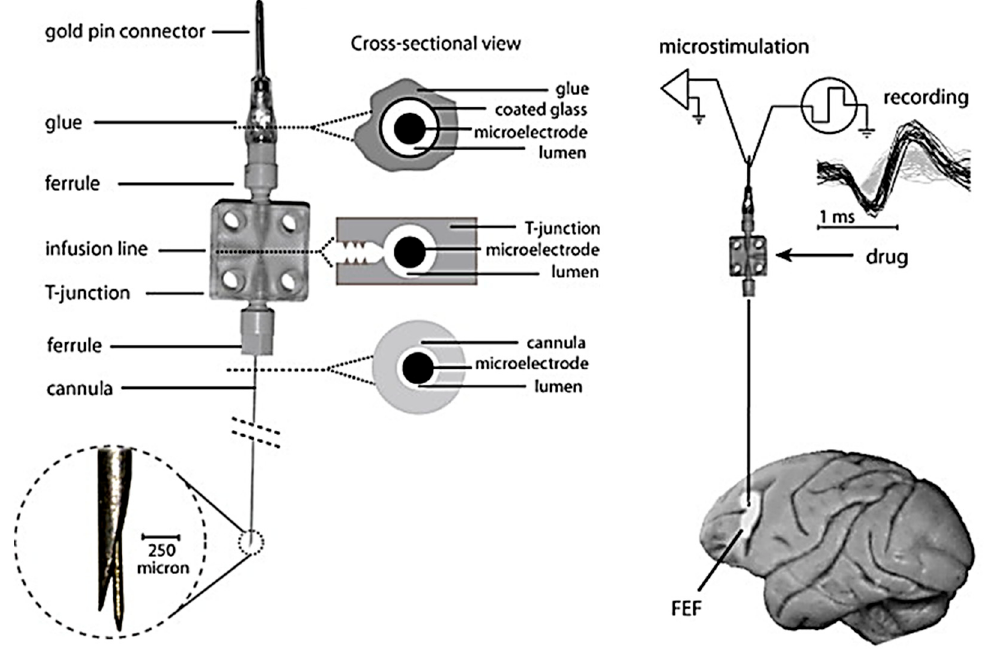
Figure 12. Microinjectrode system and its application. Briefly, a thin microelectrode passes through a 32 G cannula (OD: 236 m) which is connected to a T-junction via a ferrule. The electrode goes into a T-junction and a polyimide-coated glass tube with the terminal soldered to a gold pin. The polyimide tubing, gold pin, and ferrule are all pasted together. The middle part shows cross-sections through different parts of microinjectrode, i.e., the top ferrule, middle T-junction and bottom the cannula. An enlarged view of the microelectrode and cannula tips shows their relative position and size. A sample experiment is also displayed with single-neuron recording, electrical microstimulation and microinjection being performed in the frontal eye field (FEF). The single-neuron waveforms (black traces) segregated from background (gray traces) are also presented. Reprinted with the permission of [149].